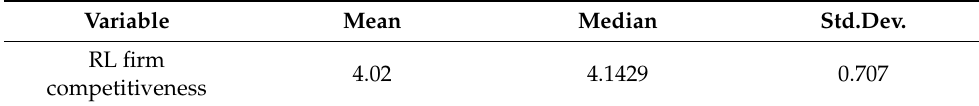
Table 4. RL firms’ competitiveness based on